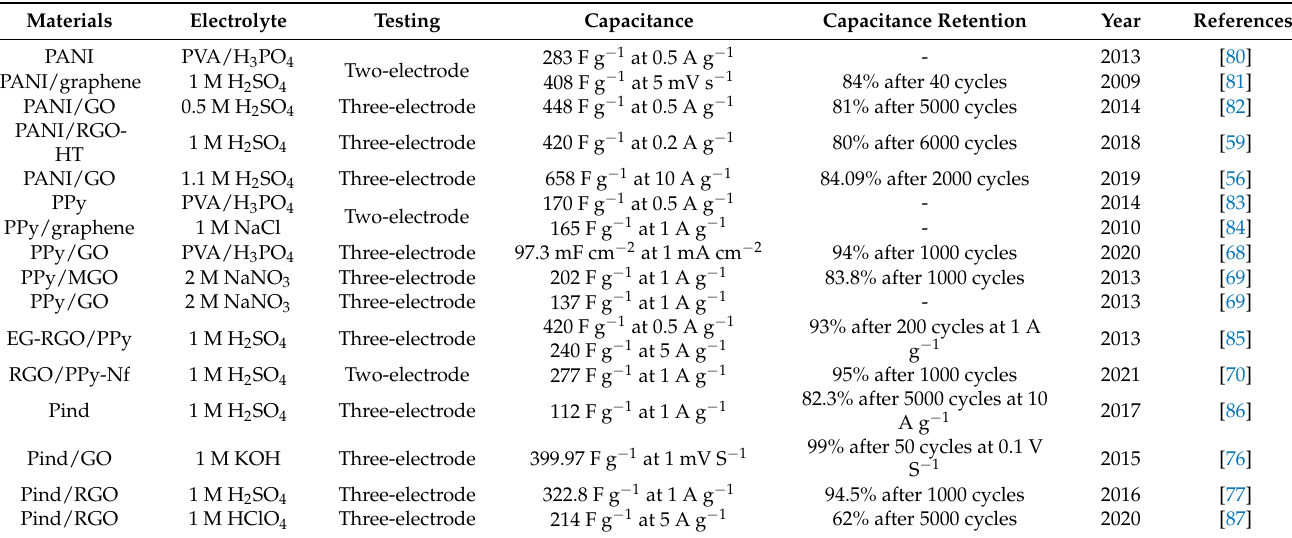
Table 1. Performance of the SCs based on graphene/CP